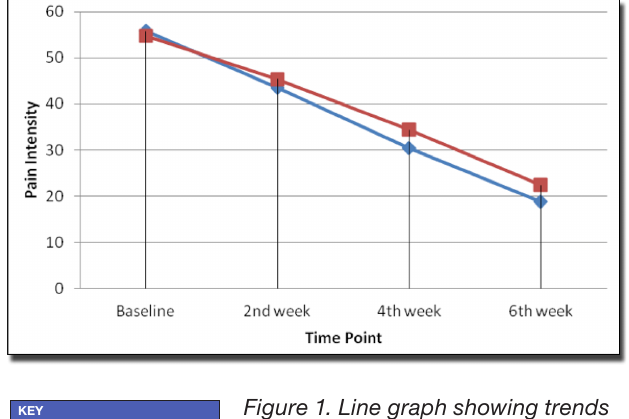
Figure 1. Line graph showing trends of pain intensity following six weeks of tele-physiotherapy and clinic